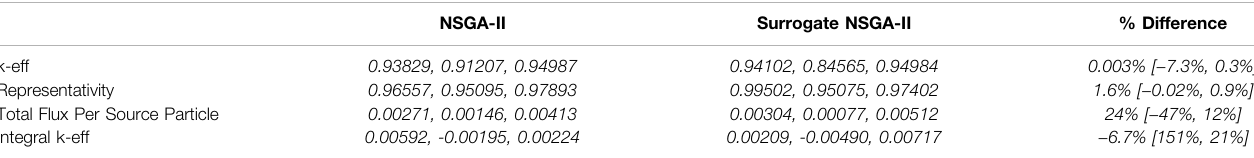
TABLE 5 | Average, Minimum and Maximum Constraint and Objective Functions of Final Pareto Front of NSGA-II and NSGA-II Surrogate Calculations. Mean values are italicized with the minimum and maximum values given in brackets below.